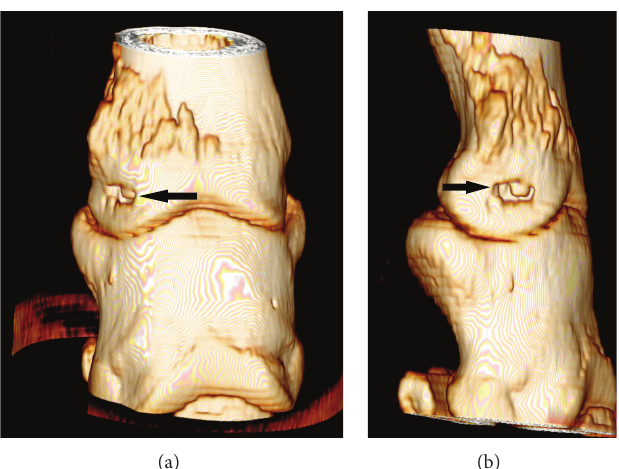
Figure 7: (a) and (b) 3D reconstruction of a CT scan of the hind right proximal interphalangeal joint area from a dorsal and lateral view. The osteolytic defect and the sequestrum (arrow) on the distal dorsolateral aspect of the proximal phalanx are visible.